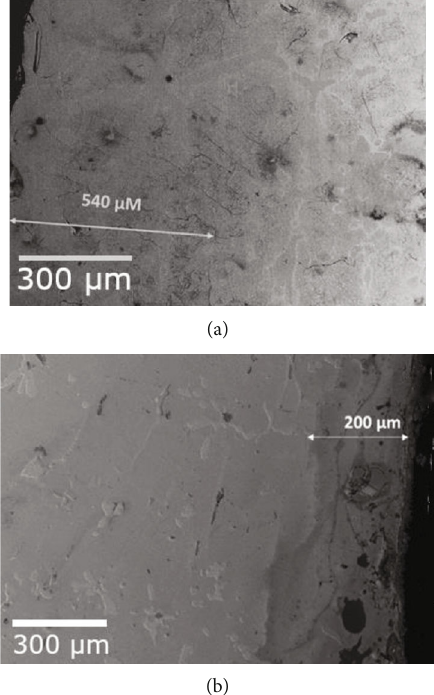
Figure 14: Crosssection of M1 (a) and M4 (b) samples after immersed in 3 M